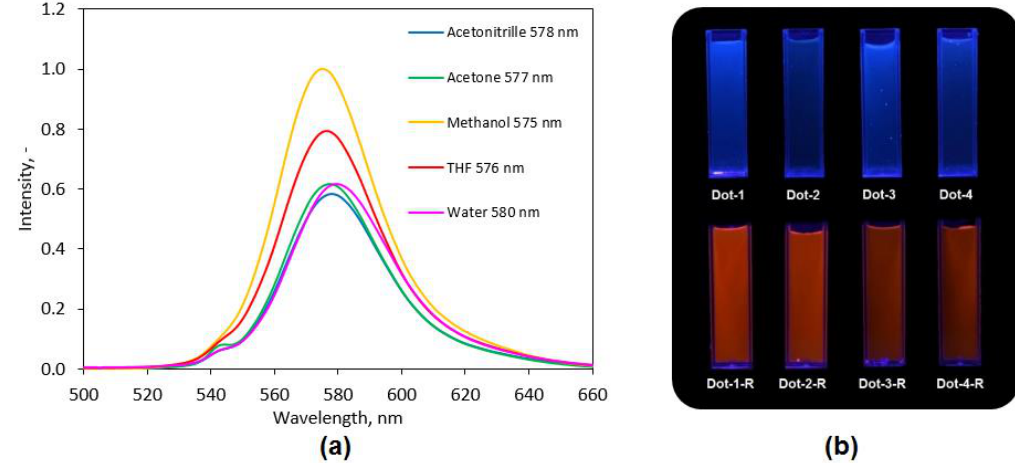
Figure 8. ( a ) Solvatochromism of the surface-modified carbon quantum dot (Dot-2-R); ( b ) prepared samples under UV light (365 nm) dissolved in distilled water.